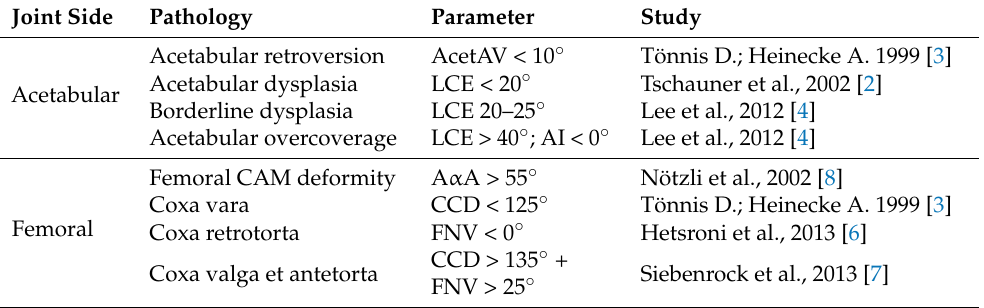
Table 1. Morphological parameters of the hip defined as precursors of osteoarthritis of the